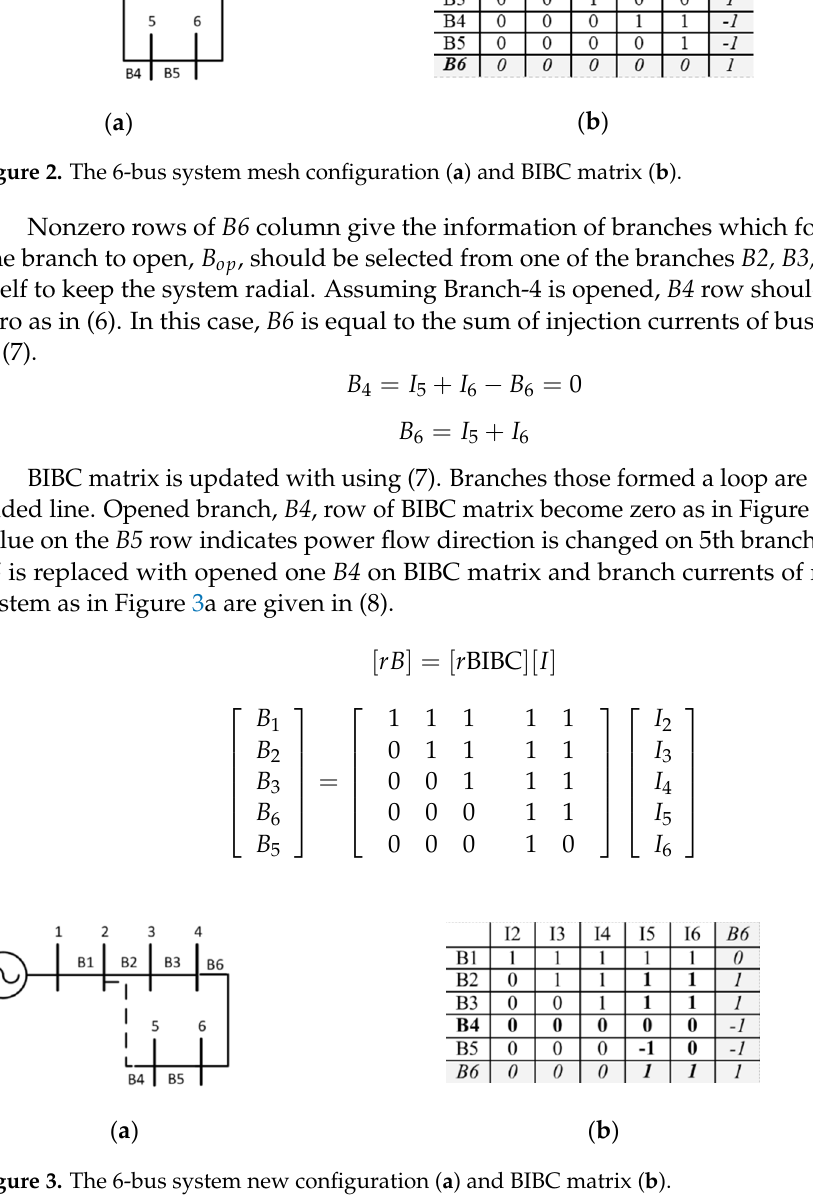
Figure 3. The 6-bus system new configuration ( a ) and BIBC matrix ( b ).